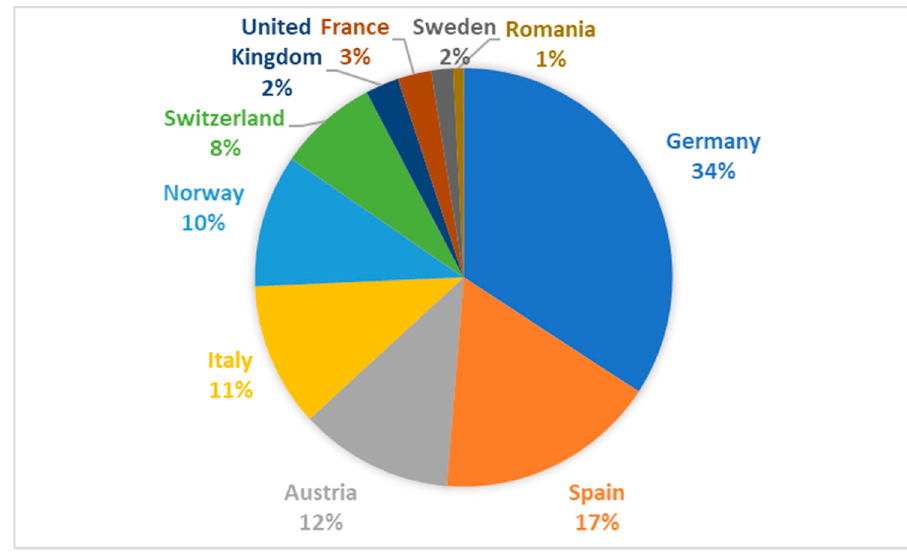
Figure 1. Percental participation from ten different European countries.